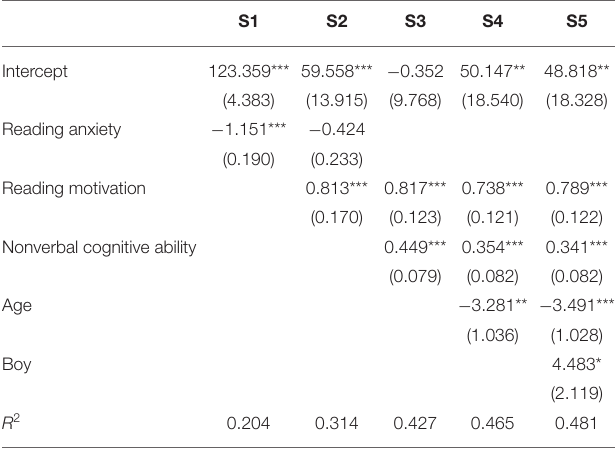
TABLE 7 | Taxonomy of models examining the relation between Basic Skills, reading anxiety, reading motivation, nonverbal cognitive ability, age, and gender ( n =